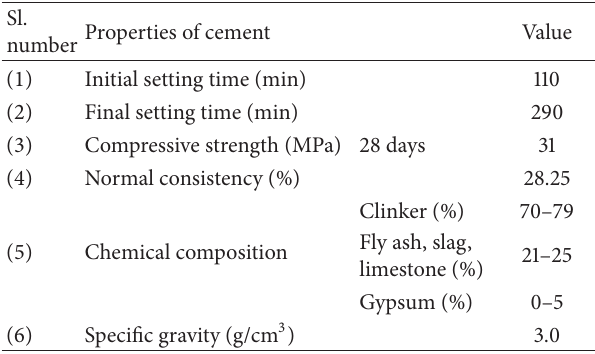
Table 1: Physical and chemical properties of the Portland composite